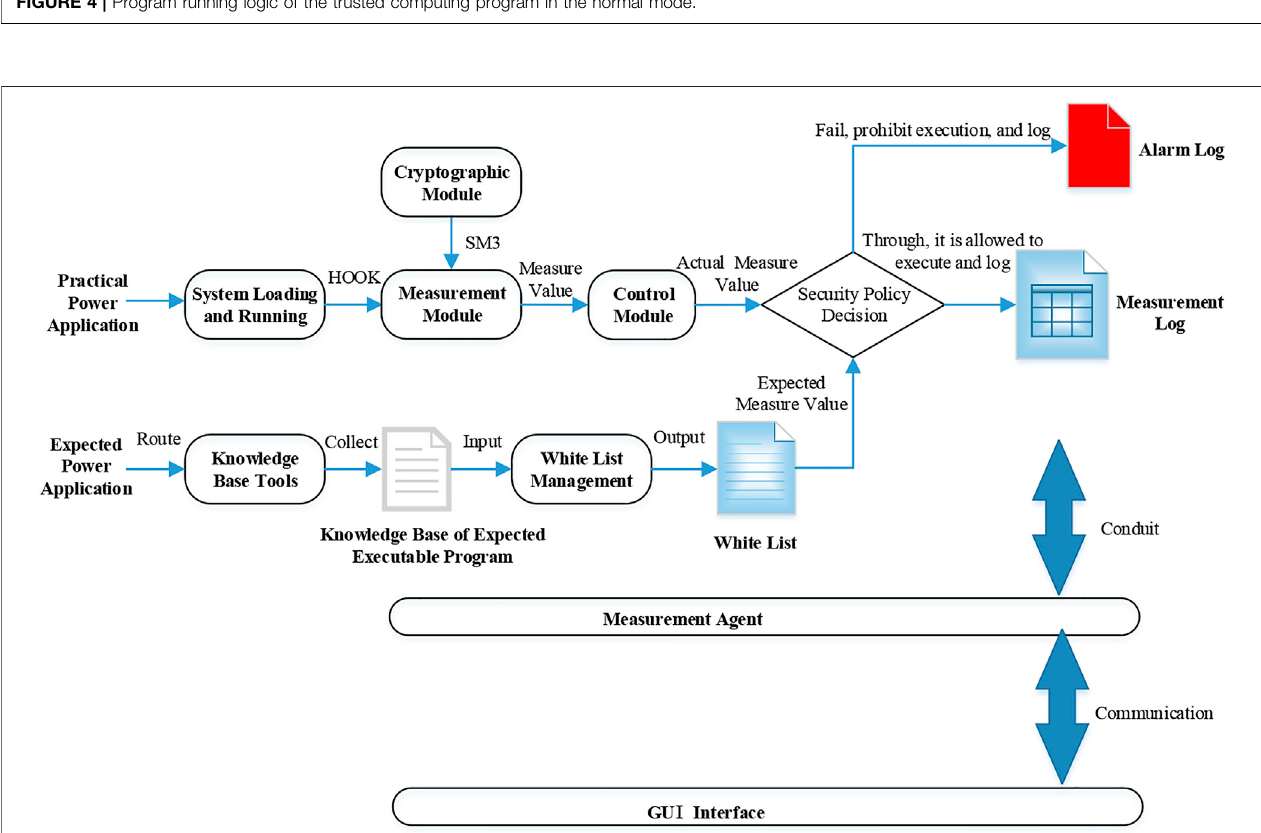
FIGURE 5 | Program operation logic of the trusted computing program in the control